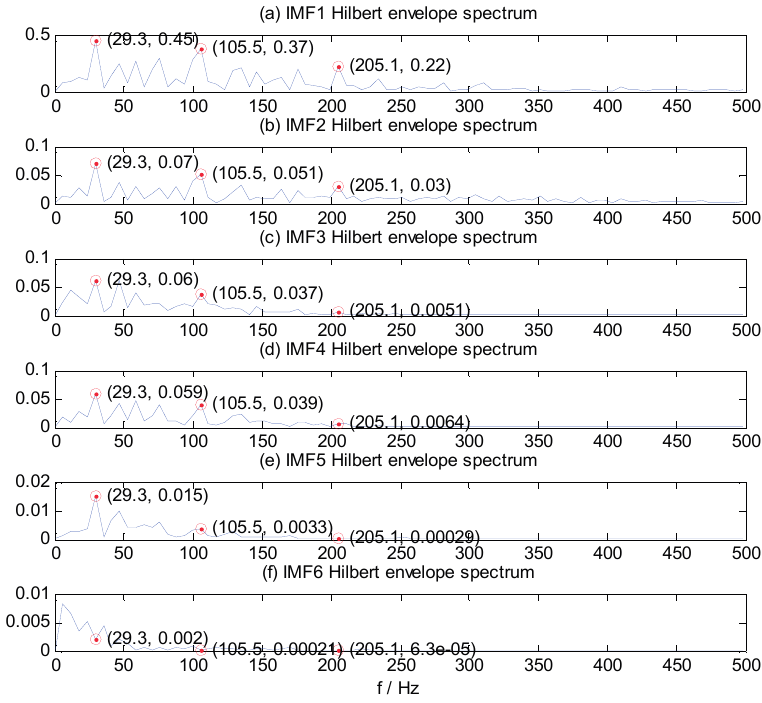
Figure 5. IMF1–IMF6 Hilbert envelope spectrum of ORF vibration signal. ( a ) IMF1; ( b ) IMF2; ( c ) IMF3; ( d ) IMF4; ( e ) IMF5;( f ) IMF6.